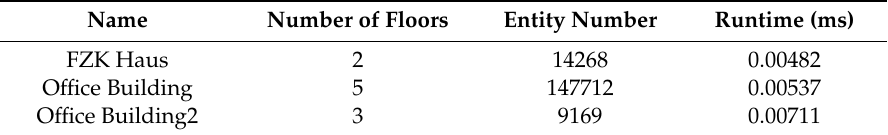
Table 3. Runtime of the geographical location mapping algorithm at di ff erent